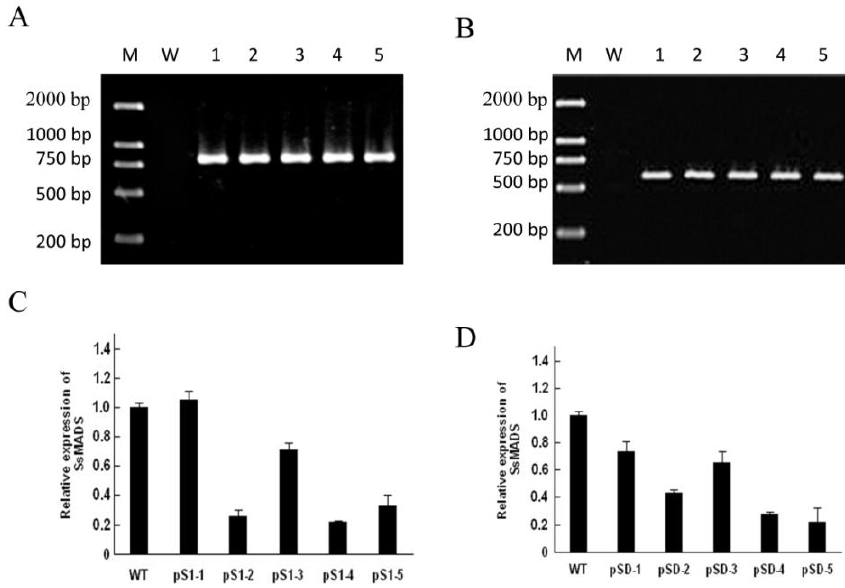
Figure 4. Silencing status of S. sclerotiorum SsMADS . ( A ) Wild-type strain and transformants identified by amplifying the hygromycin gene fragment using specific primers (hyg-F/hyg-R). M : DNA molecular size marker DL2000; W : wild type strain; lanes 1 – 5 : putative transformants pSl-1 to pSl-5; ( B ) Wild-type strain and transformants identified by amplifying geneticin-resistant gene fragment using specific primers ( gen-F / gen-R ). M : DNA molecular size marker DL2000; W : wild-type strain; lanes 1 – 5 : putative transformants pSD-1 to pSD-5; ( C , D ) SsMADS expression level in wild type ( WT ) and transformant strains pSl-1 to pSl-5 and pSD-1 to pSD-5 were determined using real-time RT-PCR. The SsMADS cDNA expression level was normalized to that of β-actin cDNA in extracts from each strain. The abundance of cDNA from the wild type was assigned a value of 1. Bars indicate standard